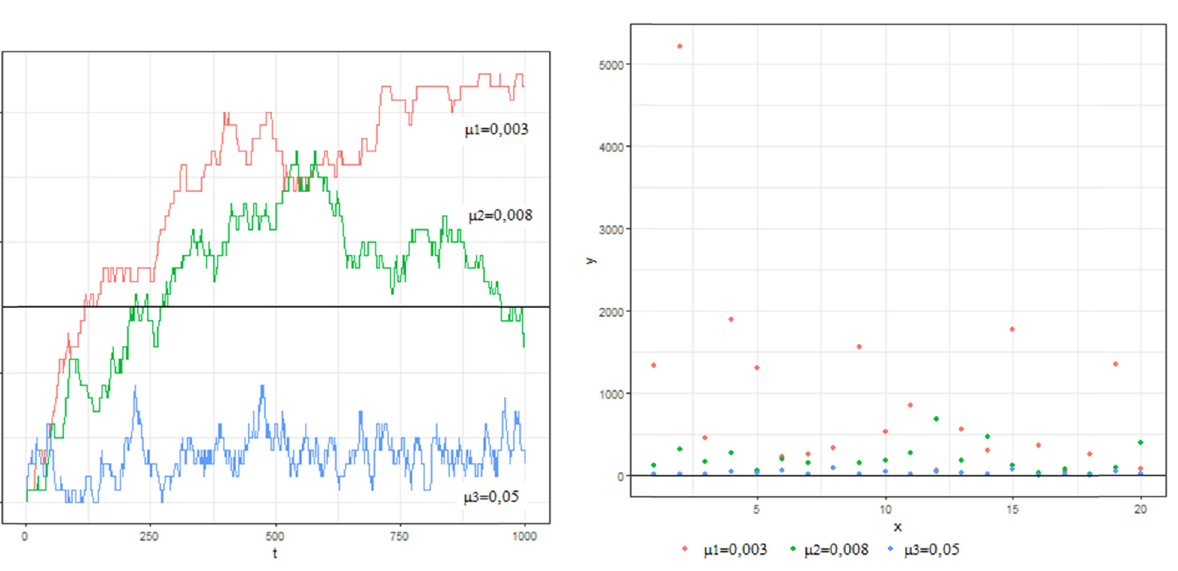
1.2 – Figure 5. In Figure 1, on the OX axis, consecutive moments of